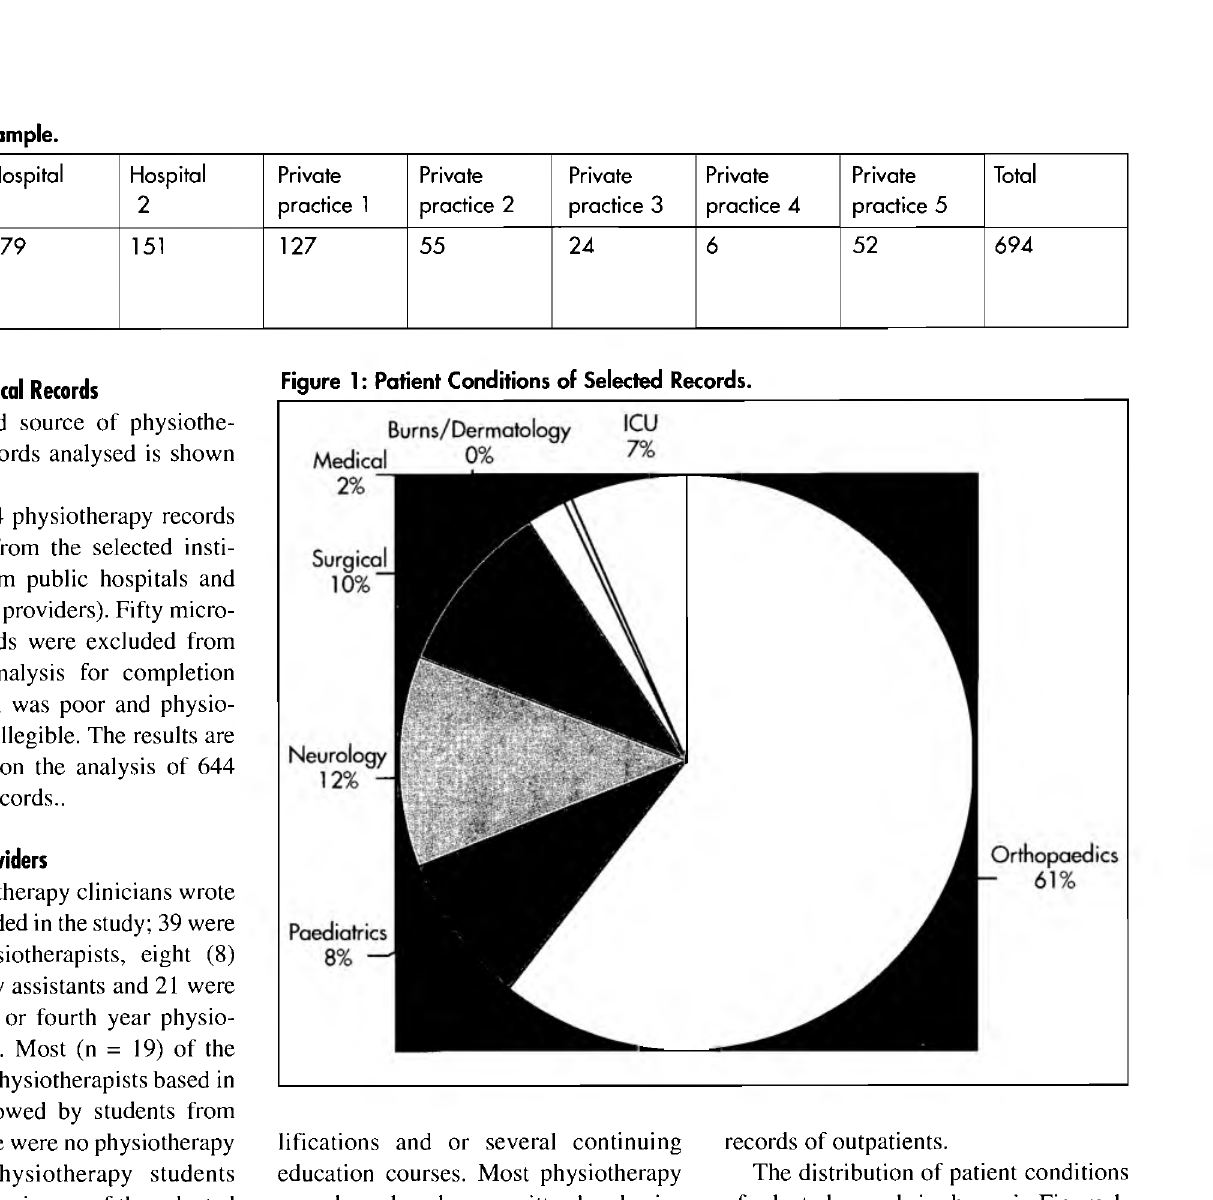
Figure 1: Patient Conditions of Selected Records. Physiotherapy Clinical